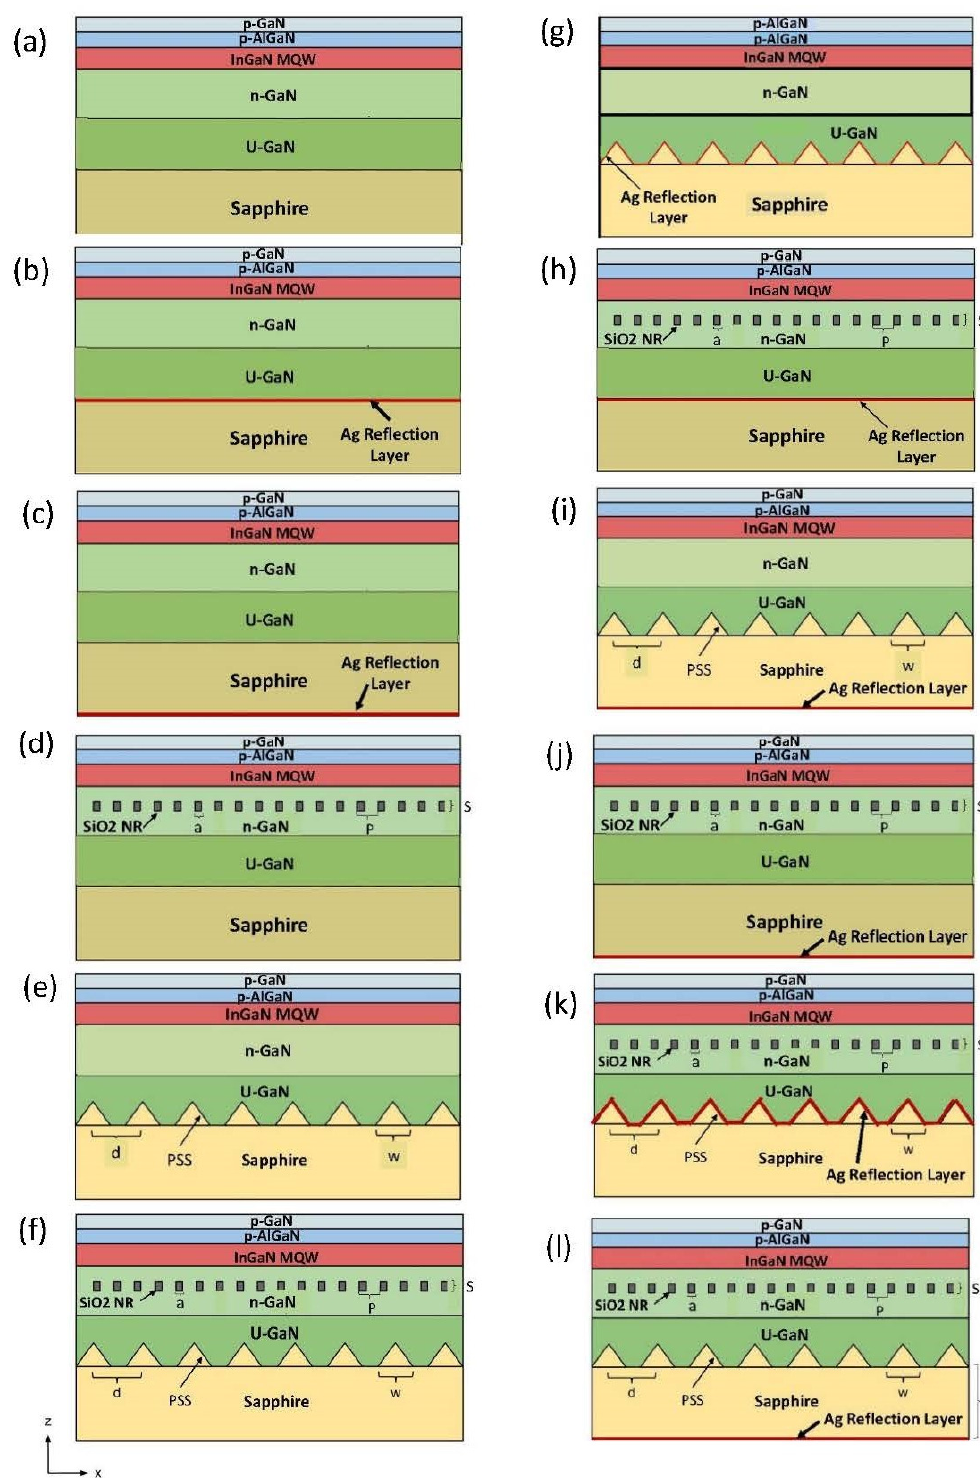
Figure 6. Diagram of LED with a patterned sapphire substrate (PSS), SiO2 NR array, and Ag Reflector . The diagram defines the PSS period ( d ), PSS width ( w ), SiO 2 NR period ( p ), SiO 2 NR width ( a ), SiO 2 NR high ( s ), and shows the x and z direction of the LED. ( a )–( l ) are explained and listed in the